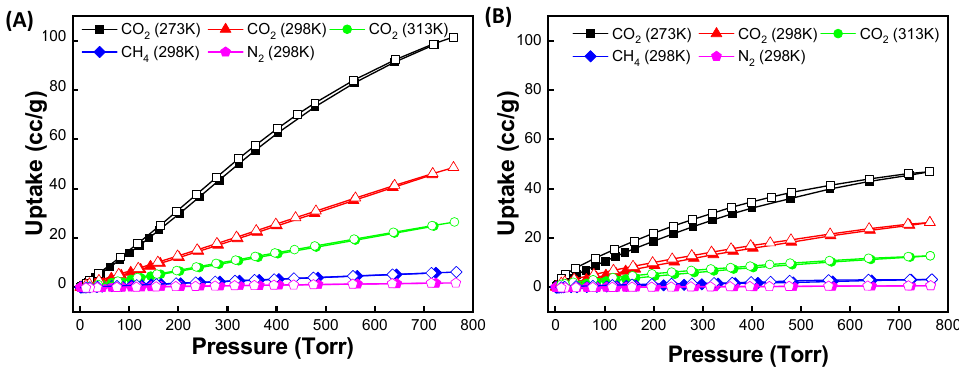
Table 1. Carbon dioxide uptake and selectivity from the air and natural gas by different MOFs at 298 K adsorption temperature and at 1 bar pressure.